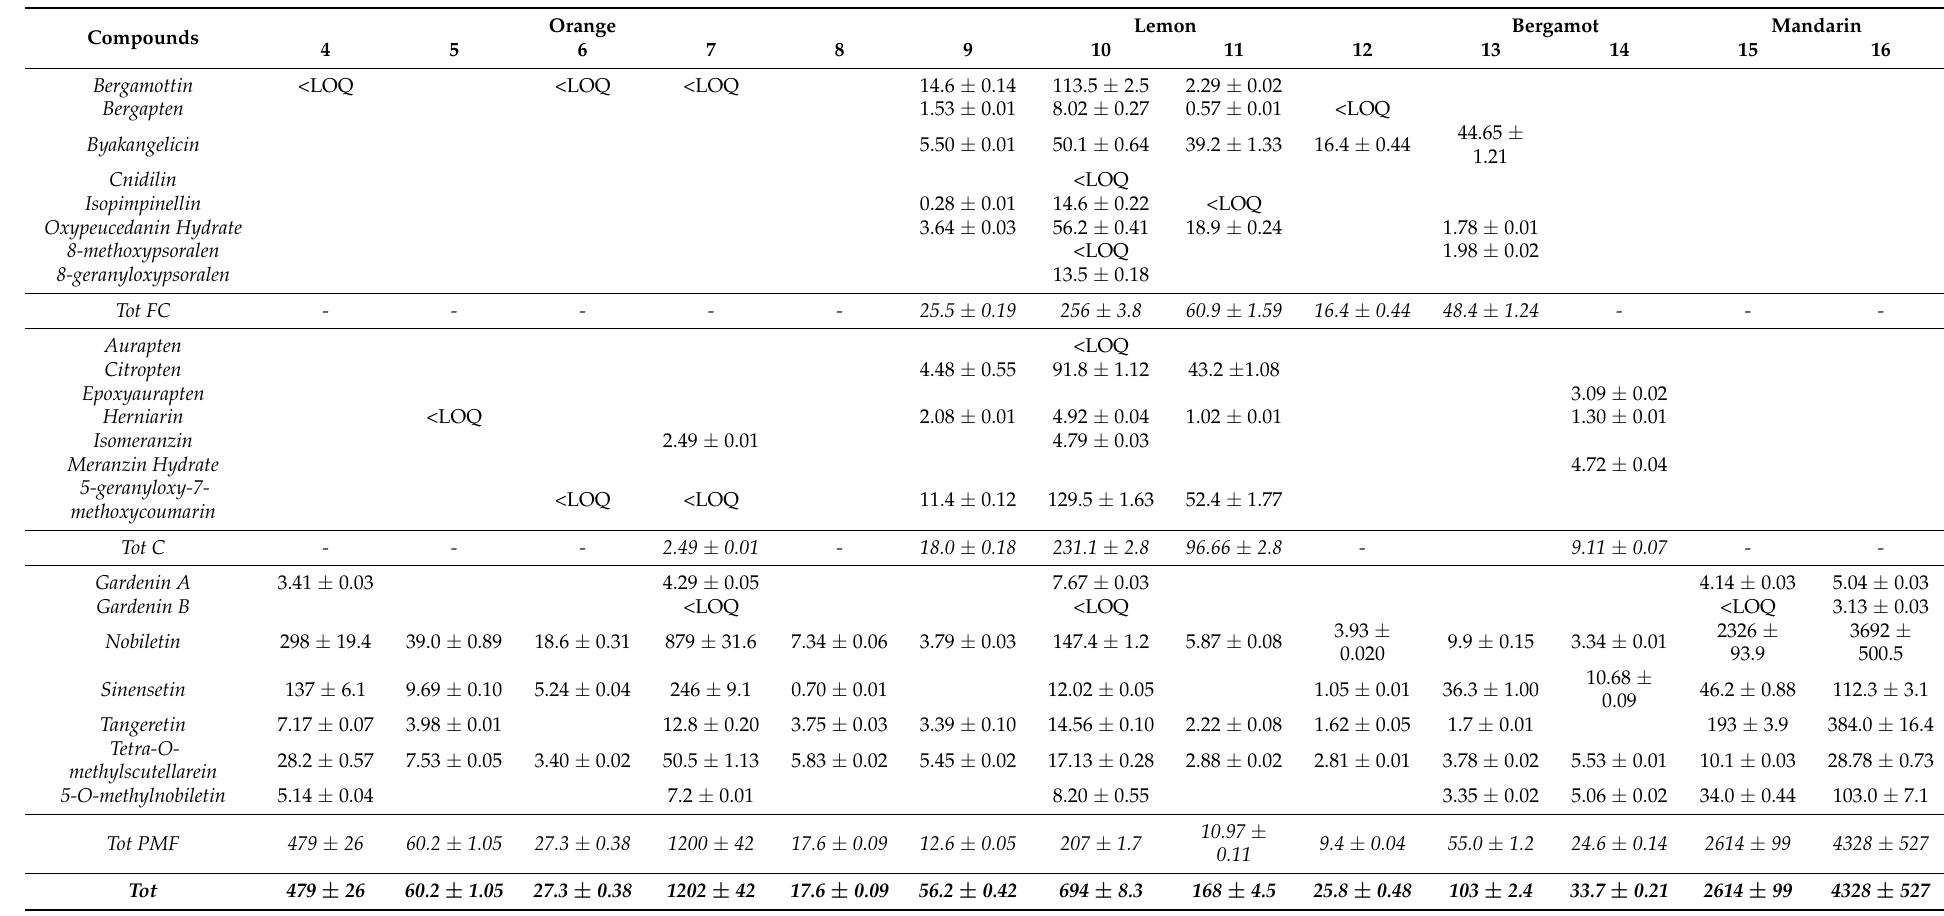
Table 4. Oxygen heterocyclic compounds contained in the samples analysed, expressed in µ g/L L ( ± expanded uncertainty) as average of three measurements.